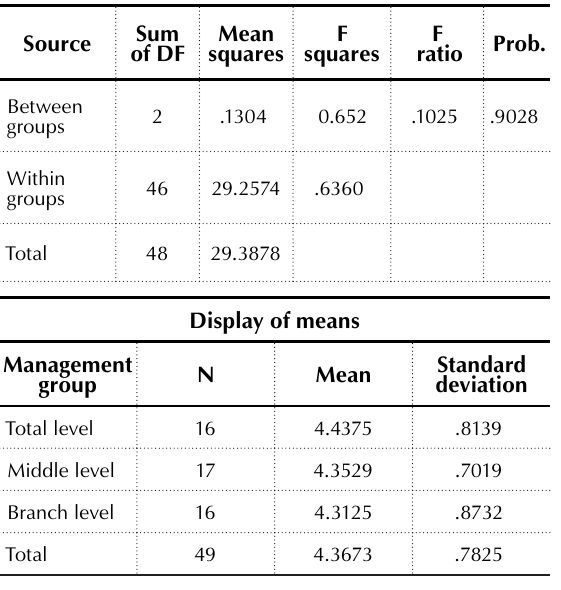
Table 2. Analysis of variance for